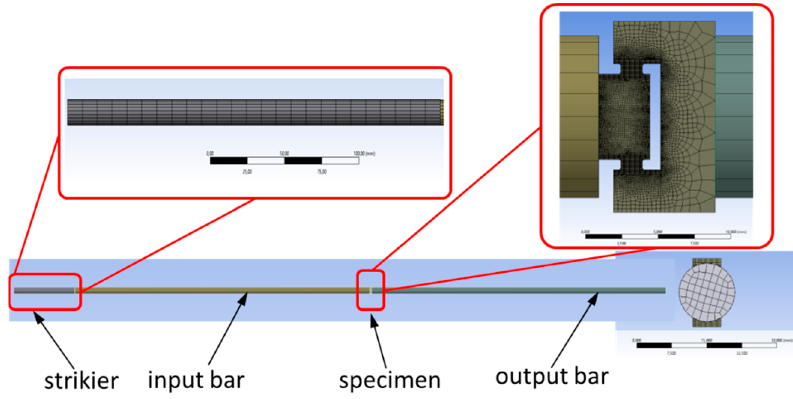
Figure 8. Finite element model of The SHPB system with the D2S specimen.